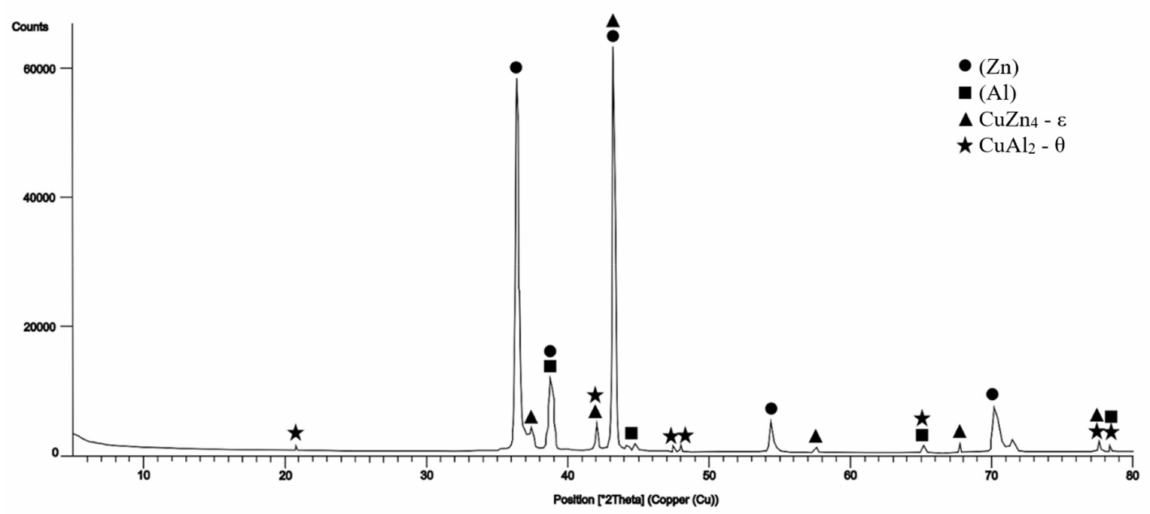
Figure 9. Diffraction record of Zn5Al3Cu solder.